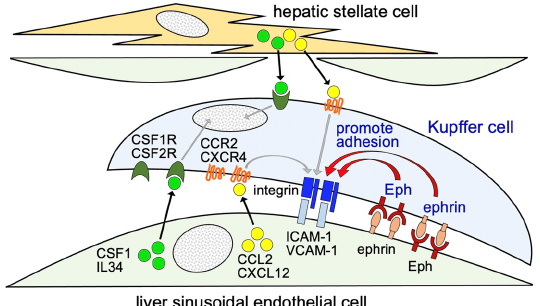
Figure 11. A schematic diagram highlighting the property of Kupffer cells colonizing the luminal surface of LSECs that is regulated by Eph/ephrin as well as certain integrins/integrin ligands, chem- okines/chemokine receptors, and growth factors/growth factor receptors for